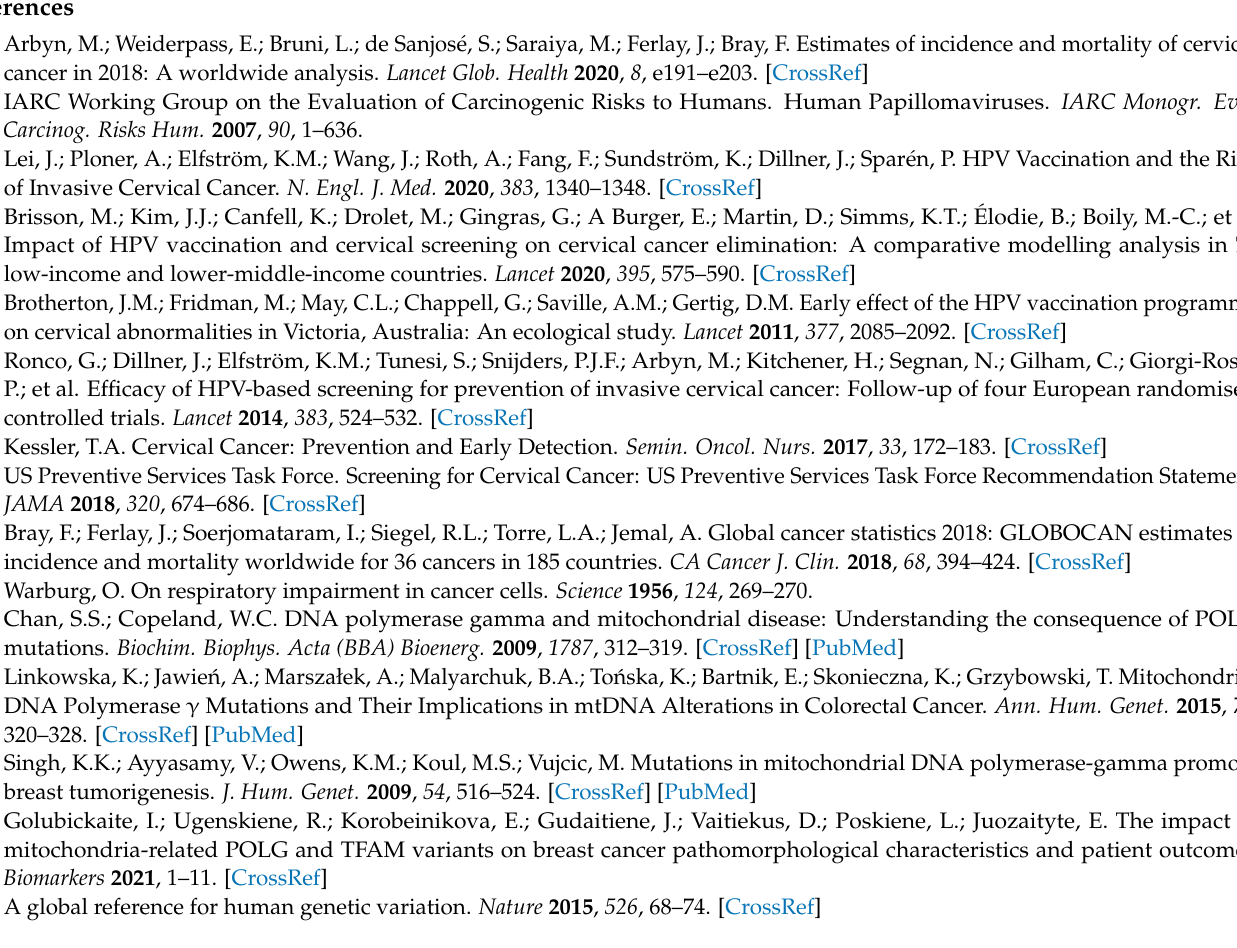
rs2307441 genotype associations with tumor and clinical data, Table S3: POLG gene rs2072267 geno- type associations with tumor and clinical data, Table S4: POLG gene rs976072 genotype